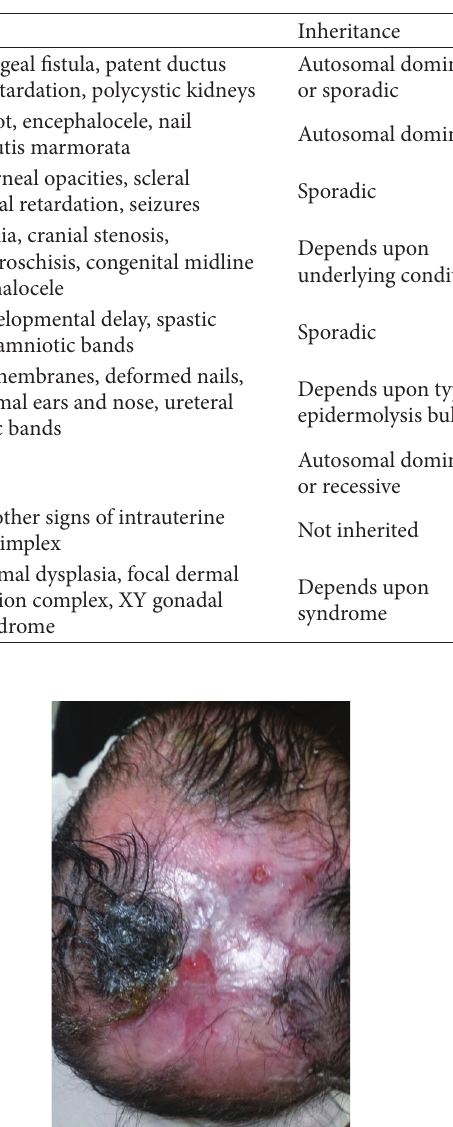
Table 1: Classification for ACC.